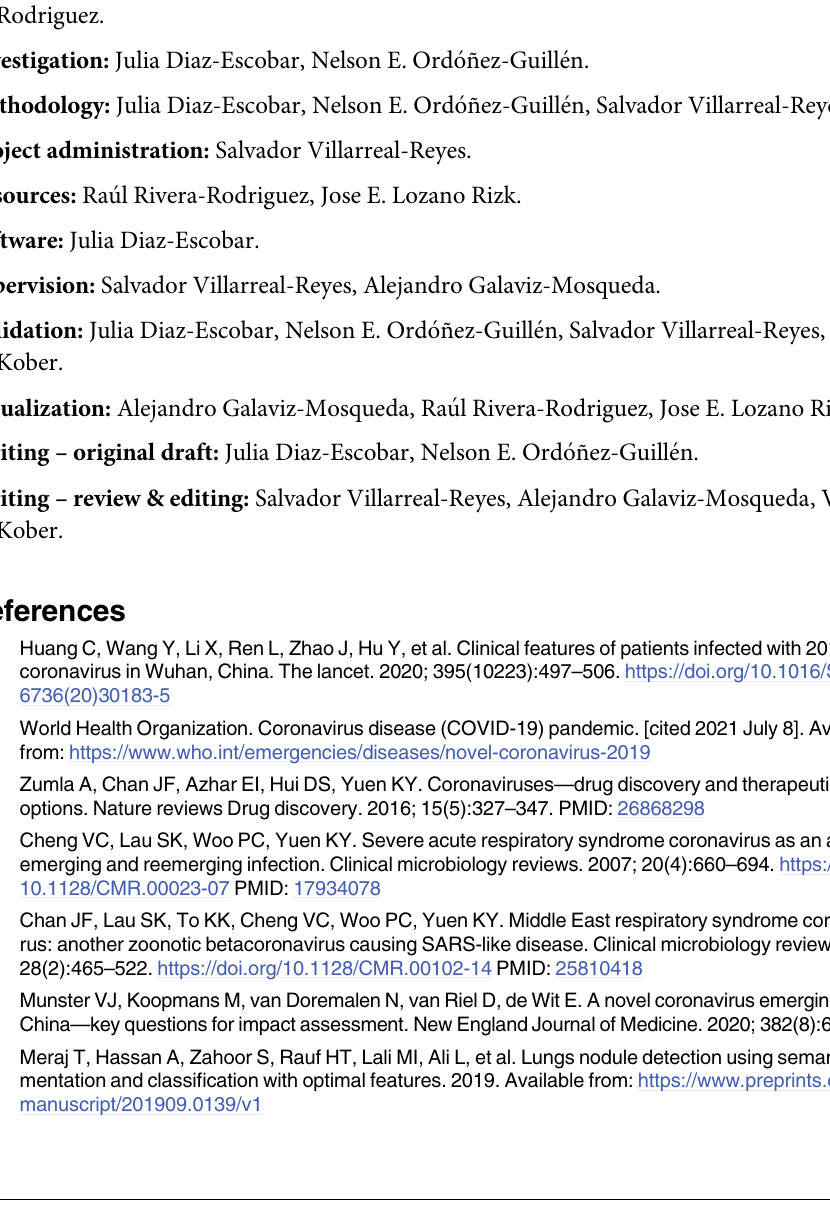
S6 File. ResNet50 experimental results. Detailed learning curves, confusion matrices, and AUC-ROC curves of each repeated 5 × 5-fold cross-validation